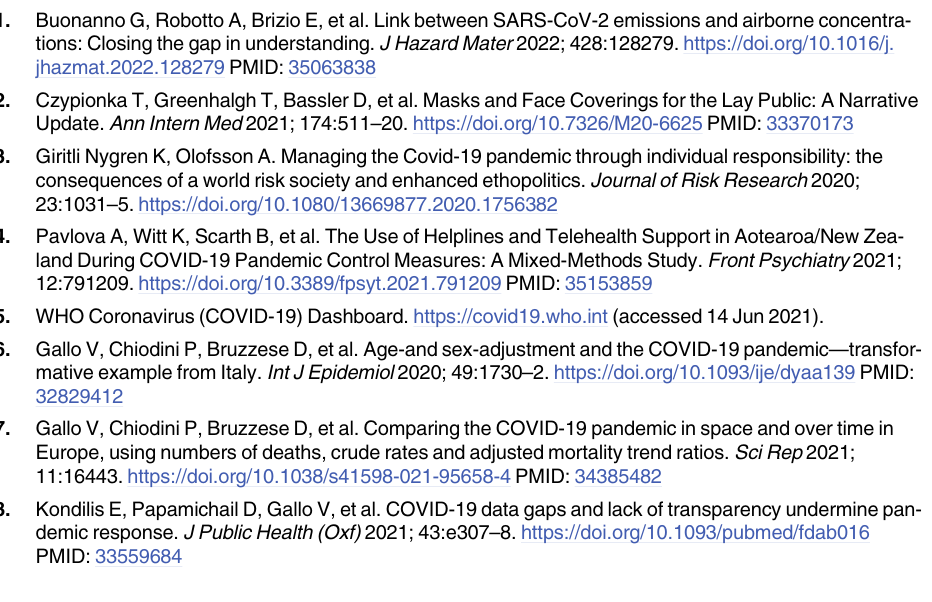
S1 Table. List of all official and unofficial sources of information used, by